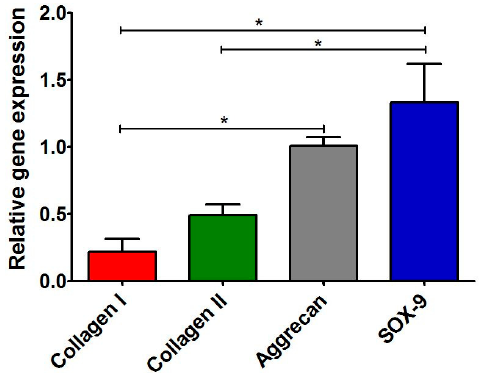
Figure 7. Relative expression of genes: collagen I, collagen II, aggrecan, and SOX-9 in chondrocytes cultured on Cur_WPI scaffold for 12 days. The results were normalized to expression levels of genes in cells cultured on polystyrene. * Significantly different results between expression level of evaluated genes; one-way ANOVA test followed by Tukey’s multiple comparison, p < 0.05.